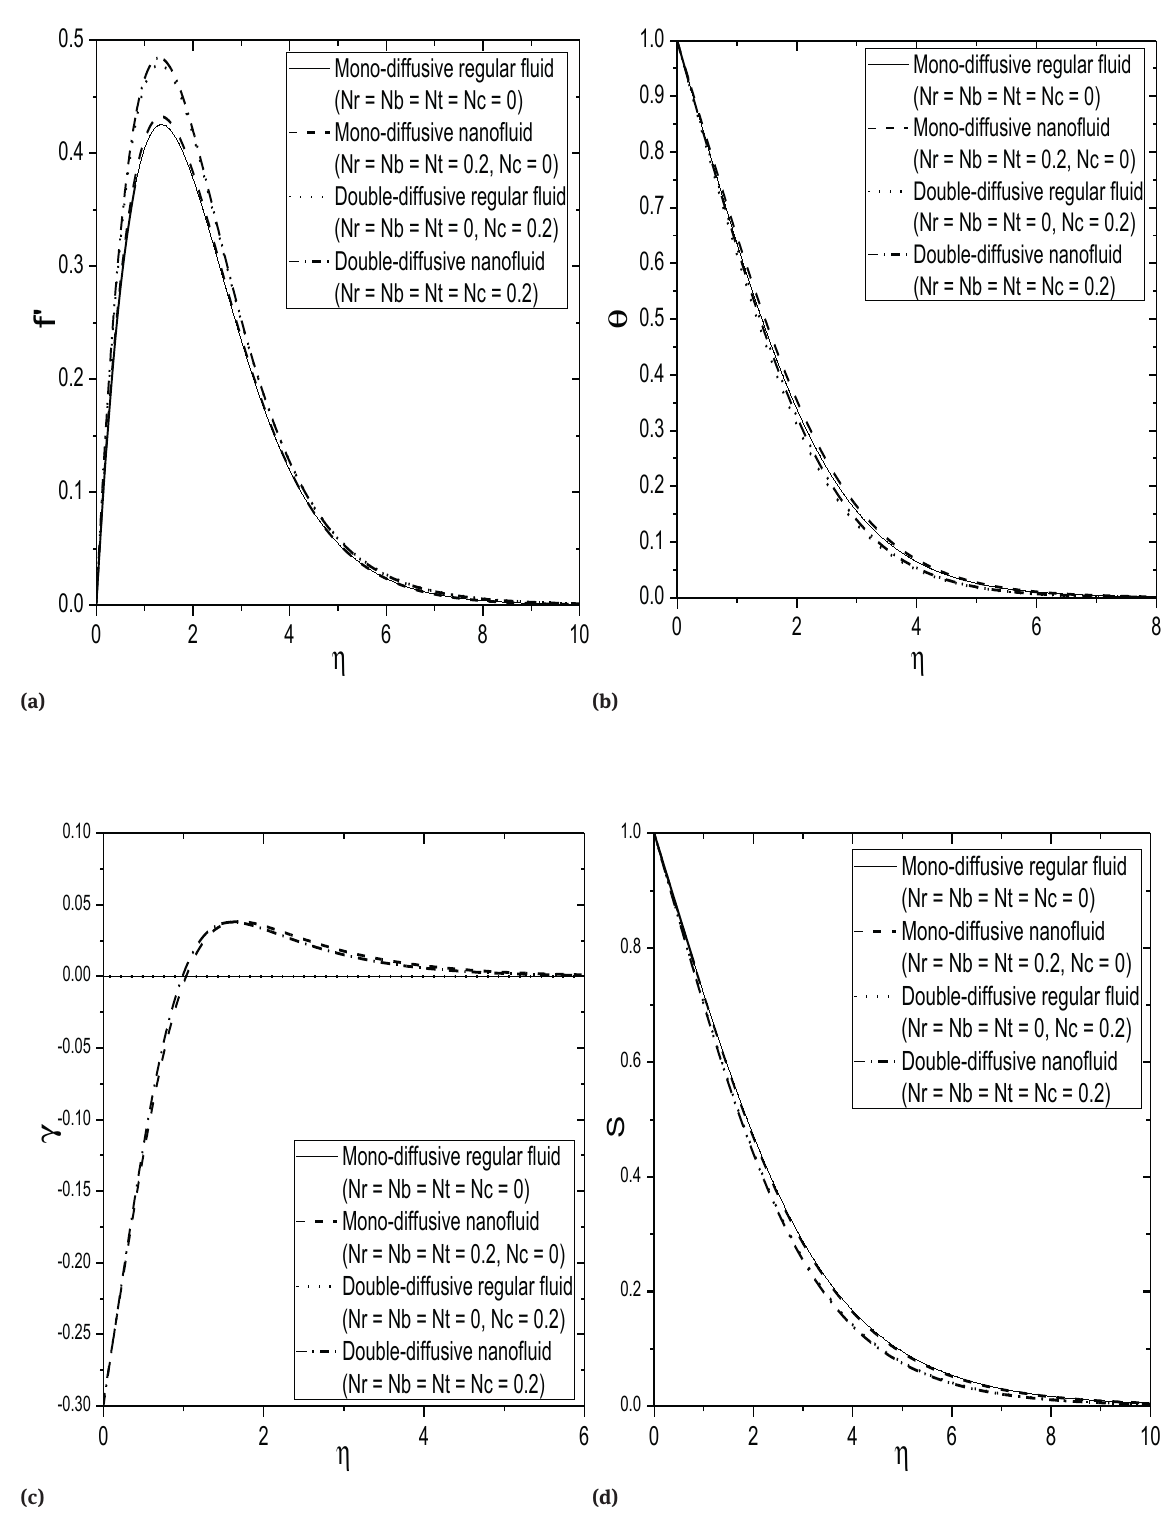
Fig. 3: Effects of mono- and double-diffusion of regular and nanofluids on dimensionless (a) velocity, (b) temperature, (c) nanoparticle con- centration and (d) regular concentration for ξ = 1.5, Fs = 0.5, Bi = 1.0, Ds = 0.2, Dc = 0.3